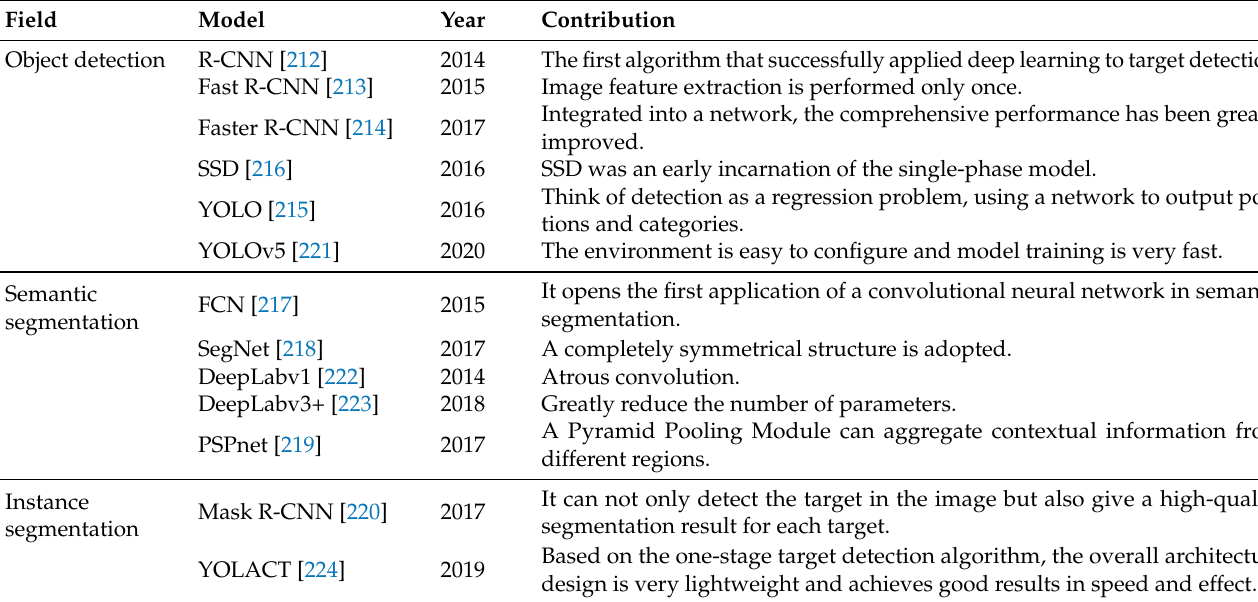
Table 11. Part of the classical image detection